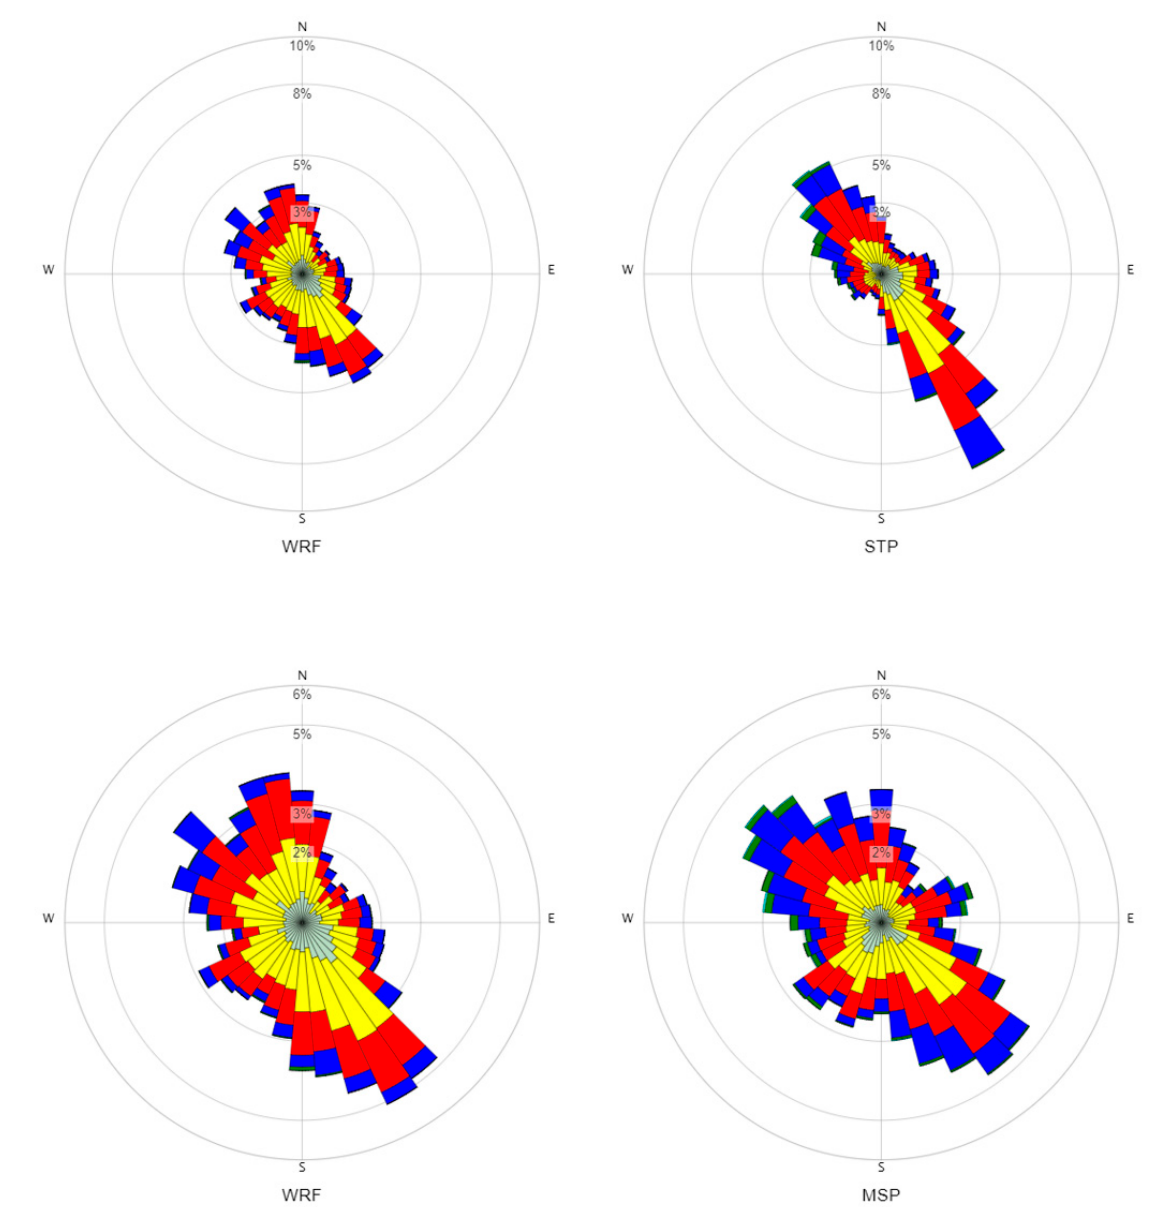
Figure A2. Wind Rose Comparison of WRF ( Left ) and Observations ( Right ) at STP ( Top ) and MSP ( Bottom ), 2011.